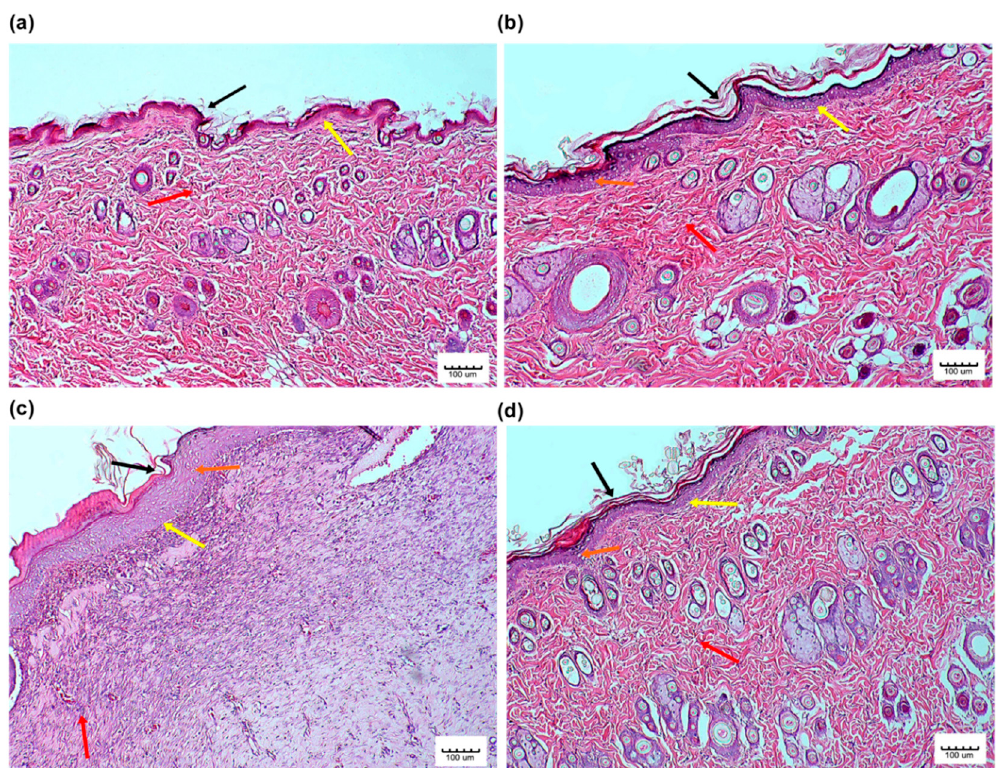
Figure 7. Photomicrograph of skin from the ( a ) normal skin tissue (Group 0); shows an intact tissue integrity especially at the epidermis (black arrow) and epidermal-dermal junction (yellow arrow) along with more fibroblast and collagen deposition (red arrow), ( b ) Palmitoyl-GDPH treated skin tissue (Group 2); shows an almost similar tissue integrity to that of the Group 0 especially the epidermis (black arrow), but a preserved epidermal-dermal junction (yellow arrow), more fibroblast and collagen deposition (red arrow), and normal apoptotic keratinocytes (orange arrow) ( c ) control skin tissue (Group 1); shows the partially destroyed tissue integrity especially the epidermis (black arrow), epidermal-dermal junction (yellow arrow), less fibroblast and plenty collagen deposition (red arrow), and complete apoptotic keratinocytes (orange arrow) and ( d ) tetracycline treated skin tissue (Group 3); shows the well tissue integrity especially the epidermis (black arrow), epidermal-dermal junction (yellow arrow), more fibroblast and collagen deposition (red arrow), and normal apoptotic keratinocytes (orange arrow). Magnification at 10× (H & E).